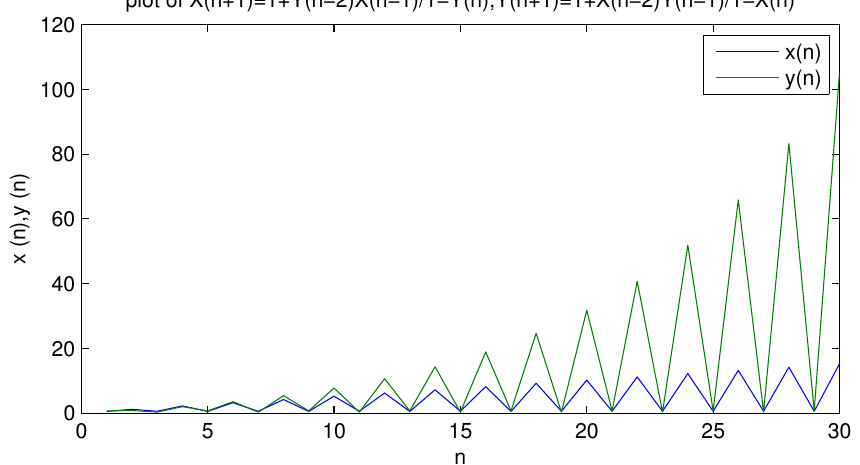
Figure 3. Expresses the solution of System (3) when the initial values x − 2 = 0.5, x − 1 = 1.2, x 0 = 0.6, y − 2 = 0.7, y − 1 = 0.8 and y 0 =